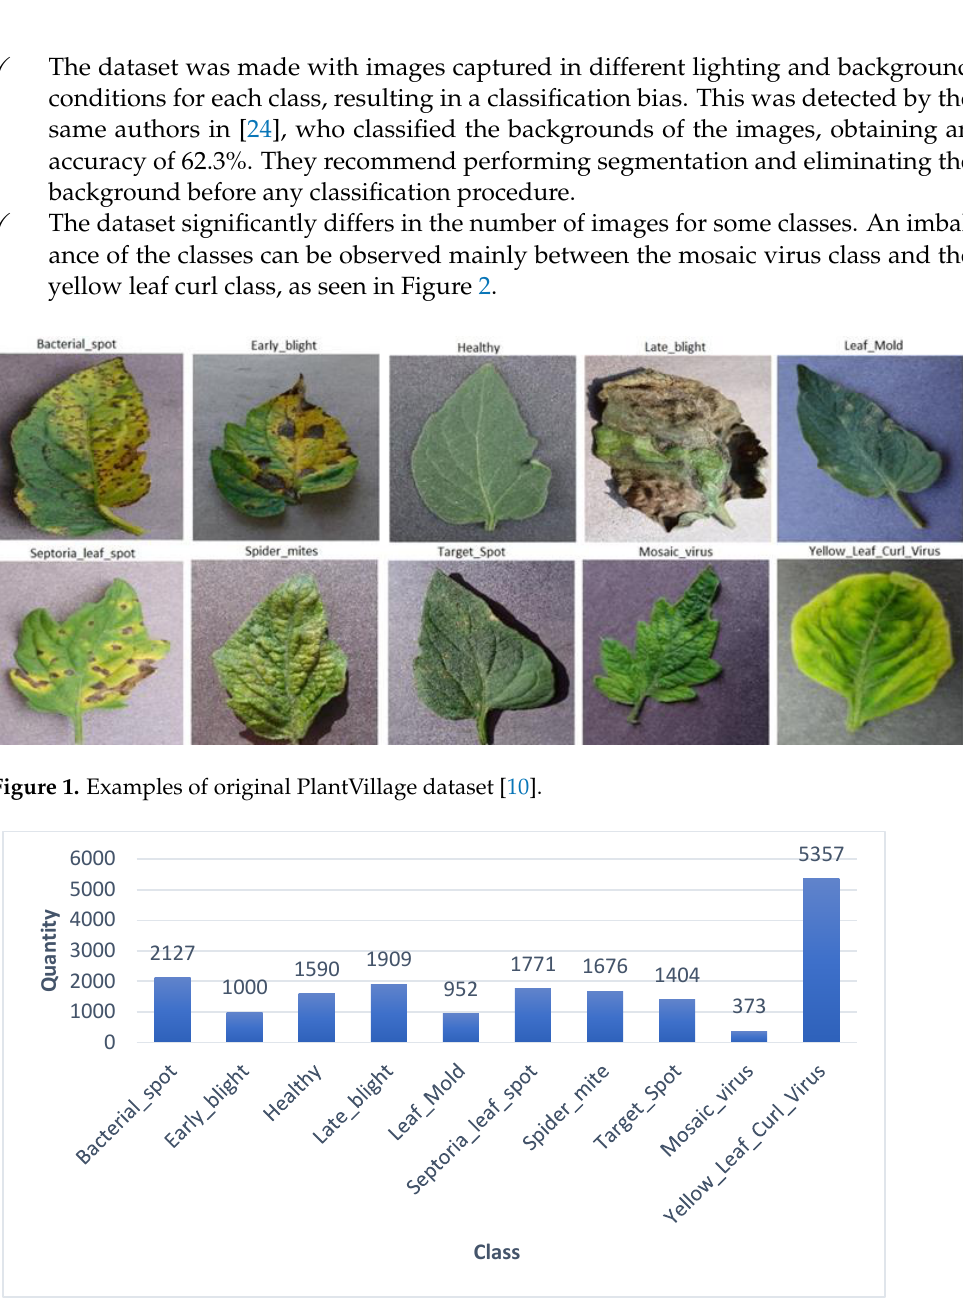
Figure 1. Examples of original PlantVillage dataset [10].